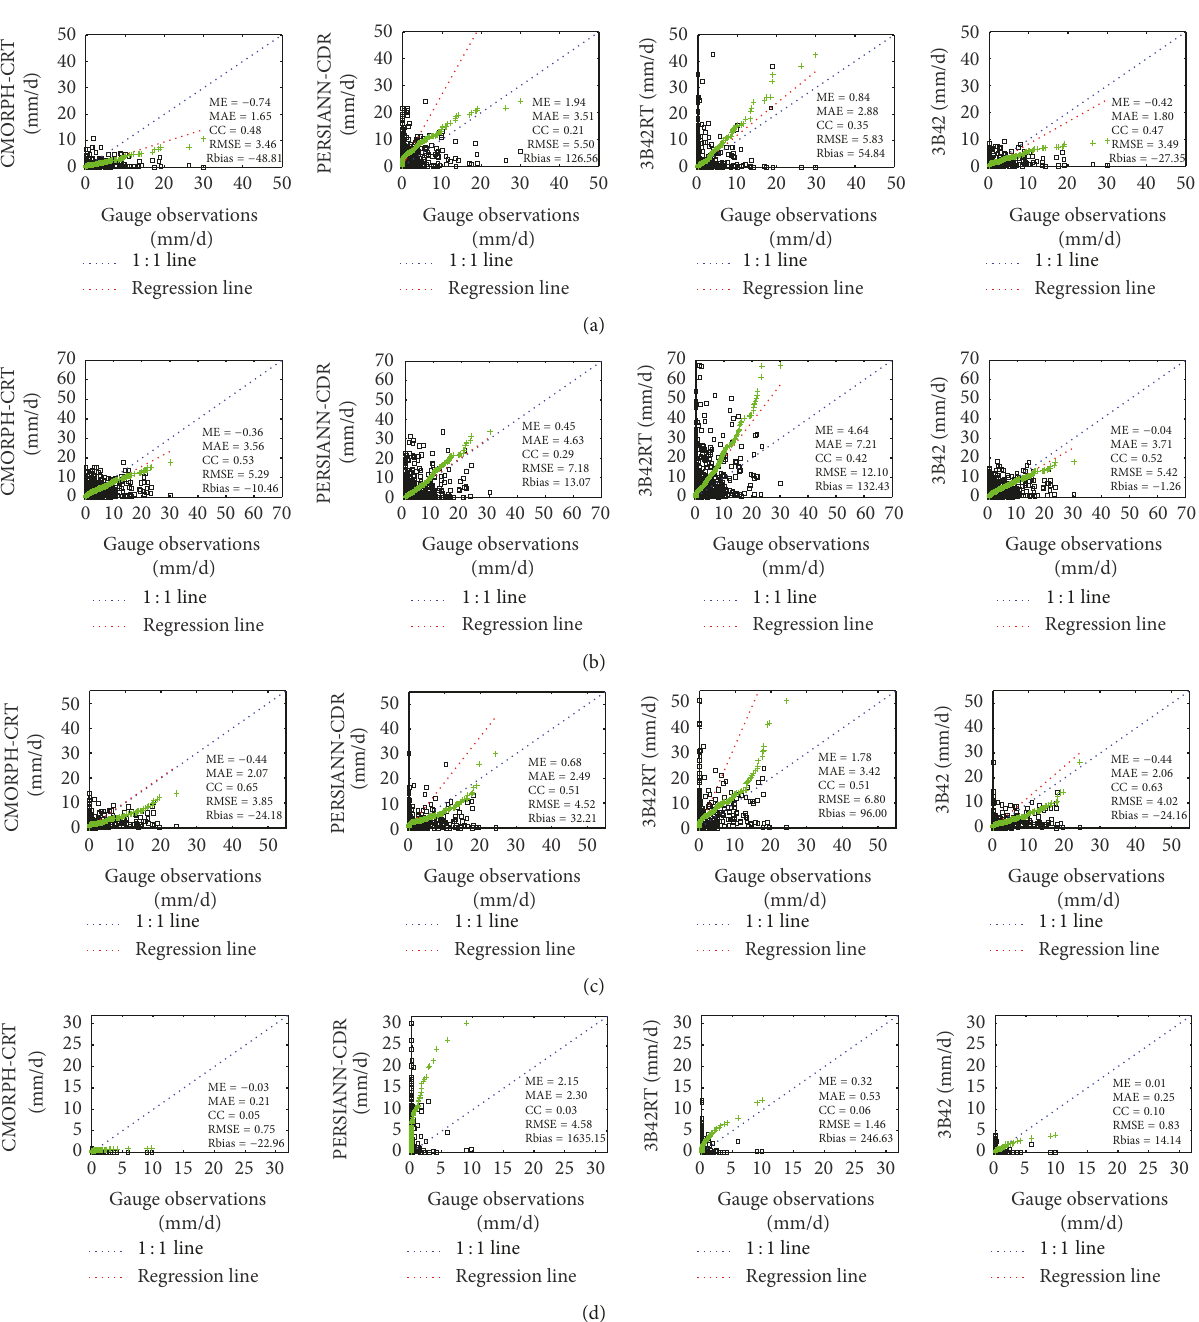
Figure6:Quantil-Quantil(green)plotsandscatterplots(black)ofbasinaveragedprecipitationfromgaugeobservationsversussatellite-based estimates for (a) spring, (b) summer, (c) autumn, and (d) winter during the period 2008 to